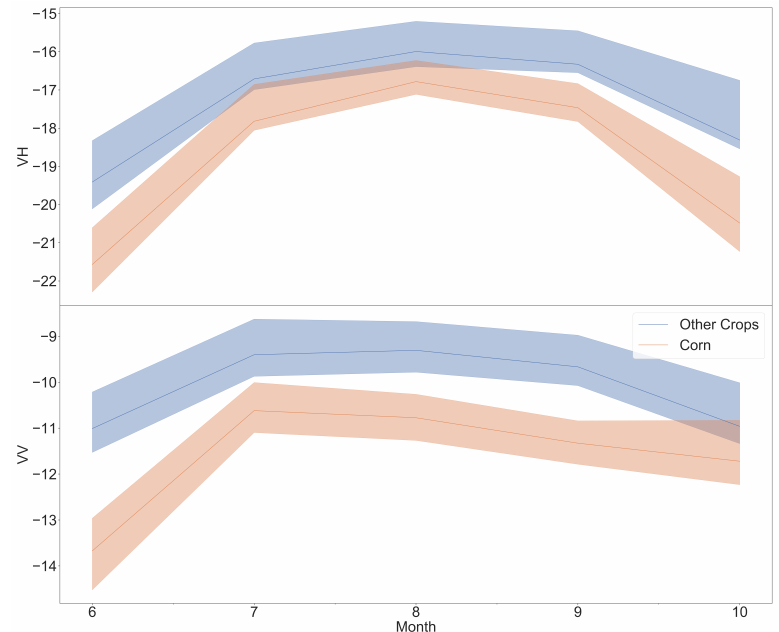
Figure 9. Median of the VV (Single co-polarization, vertical transmit/vertical receive) and VH (Dual-band cross-polarization, vertical transmit/horizontal receive) bands for monthly composites from all of the training points. Each line was filled with a 40–60% percentile deviation for each